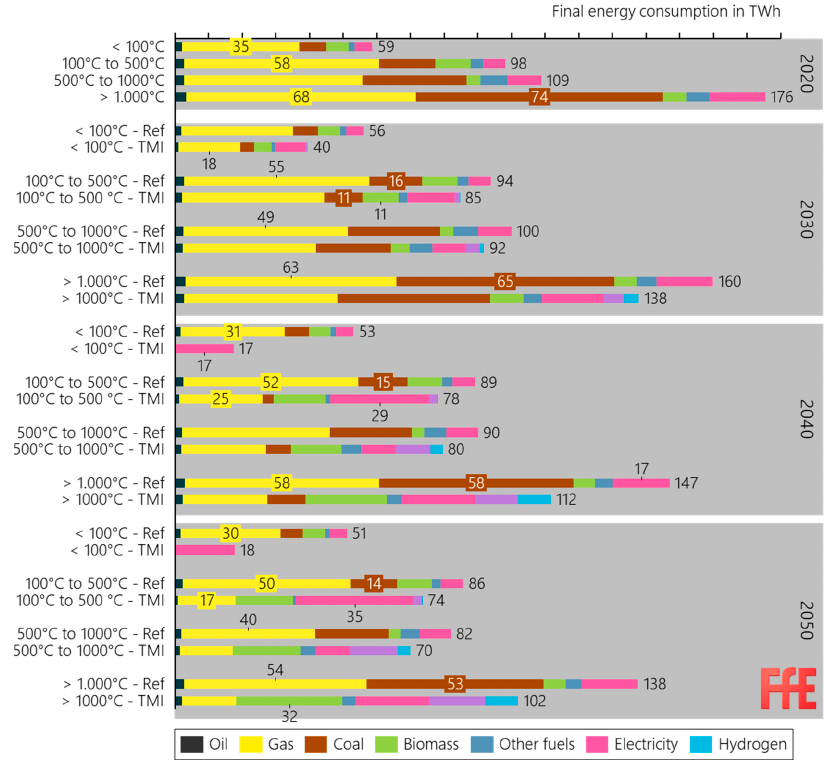
Figure A3. Energy consumption of process heat by temperature level and energy carrier in Reference and TMI scenarios between 2020 and 2050.